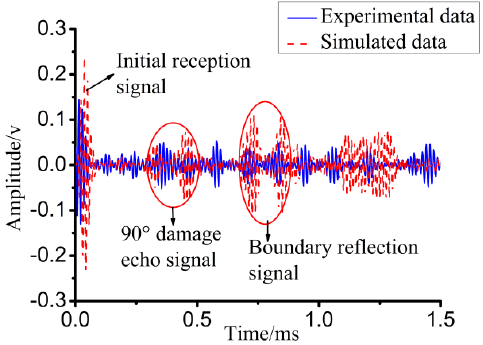
Figure 27. Comparison between experimental results and simulation results of pipe with 90° circumferential damage.